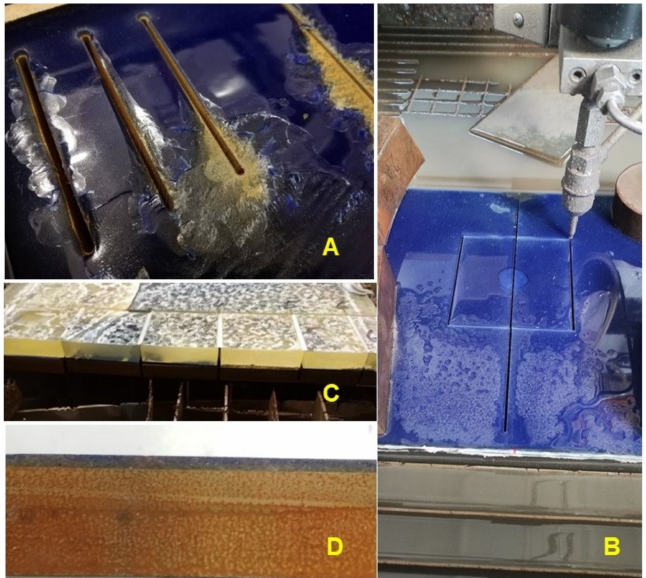
Figure 1. Preparation of test specimens—sampling from the panel after local treatment of the inor- ganic surface: ( A ): damage to the inorganic surface during sampling at different cutting parameters by AWJ technology, ( B ): cutting by AWJ technology of test specimens with a protective layer of two- component laminating epoxy resin on the functional surface, ( C ): a cross-sectional view of the test panel—sandwich layer—metal, inorganic surface, laminating epoxy resin layer, ( D ): test specimen after removing the separation layer with a protective layer of two-component laminating epoxy resin on the functional surface.